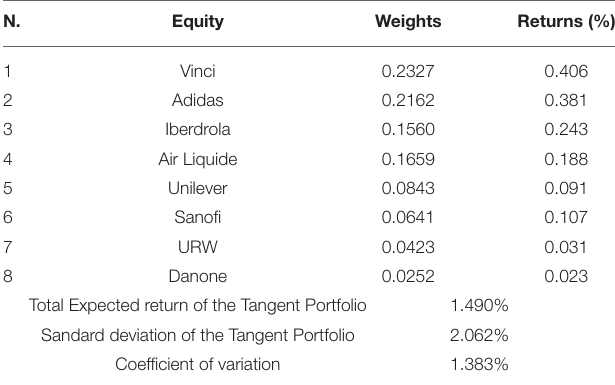
TABLE 6 | Composition of the Tangent Portfolio for in-sample (monthly) data. N.